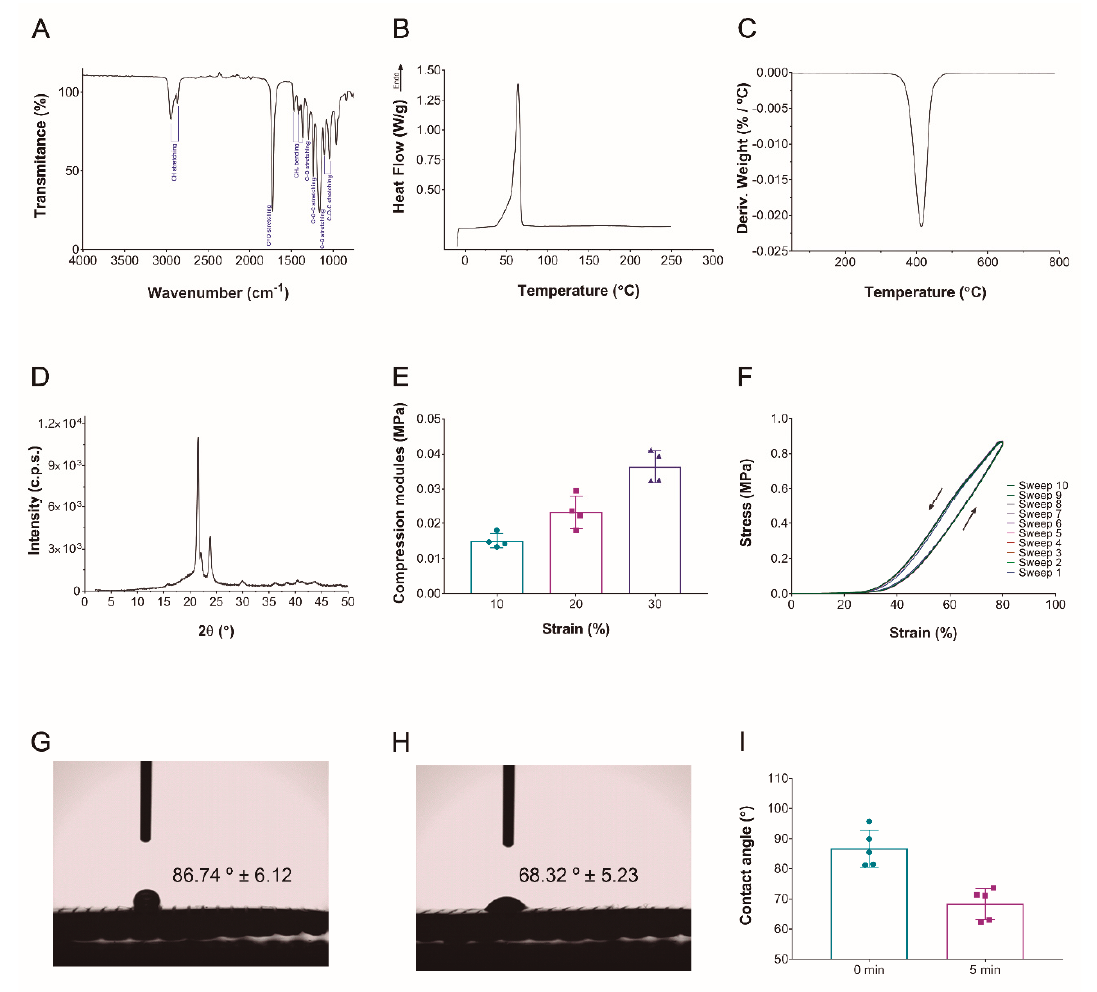
Figure 2. Hybrid PCL scaffold characterization. ( A ) FTIR spectrum. ( B ) DSC curve. ( C ) DTGA curve. ( D ) XRD pattern. ( E ) Compression module values calculated at different strain values. ( F ) Stress-strain curves of a ten compression-decompression cycle. ( G ) Water contact angle at initial time. ( H ) Water contact angle at 5 min. ( I ) Mean value and standard deviation of contact angle values at 0 and 5 min.